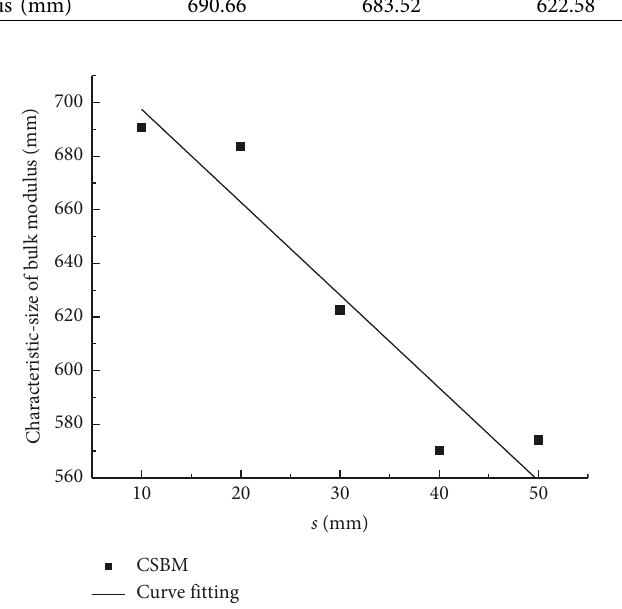
Figure 7: Fitting curve of CSBM and